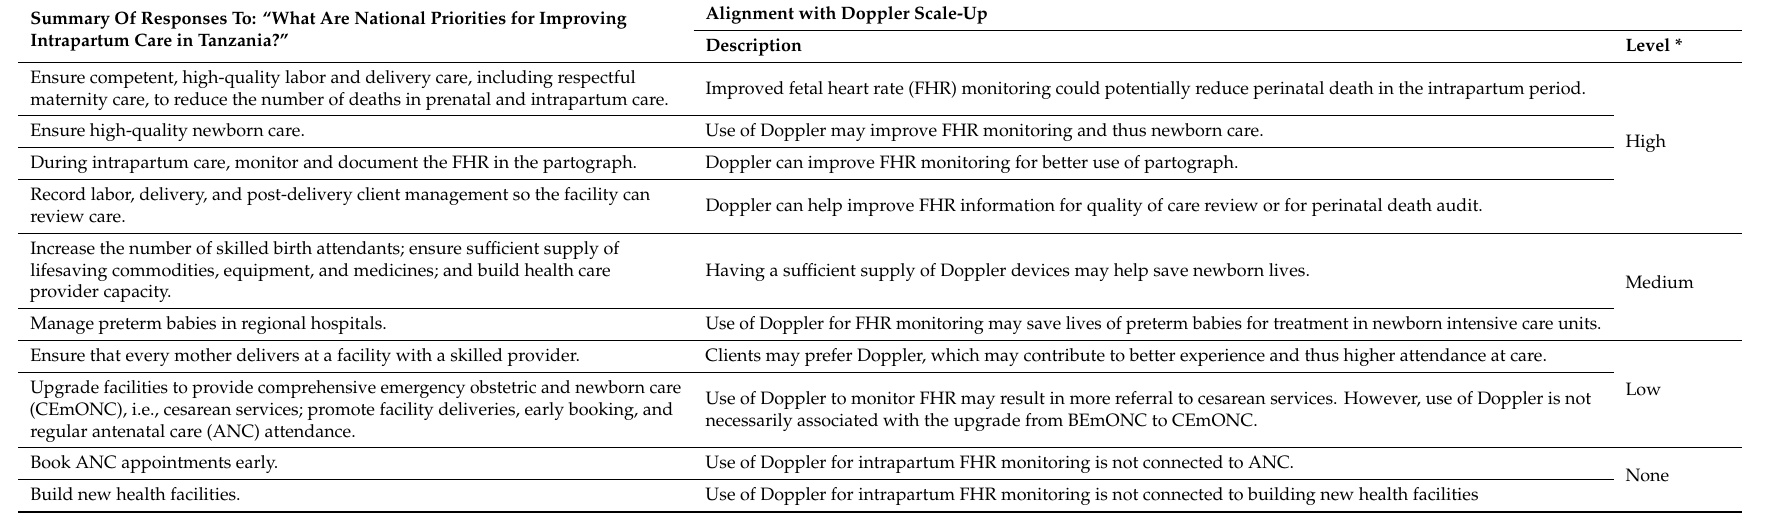
Table 3. Summary of national priorities mentioned by interviewees and alignment to scale-up of